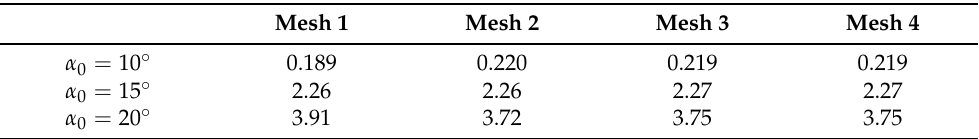
Figure 4. ( a ) Fluid mesh. ( b ) Structure mesh. Table 4. Power efficiency η (%) for coarse to refine mesh for hydrofoil 1, f ∗ = 0.025 and ∆ h = 0.8 m, as a function of pitching amplitude α 0